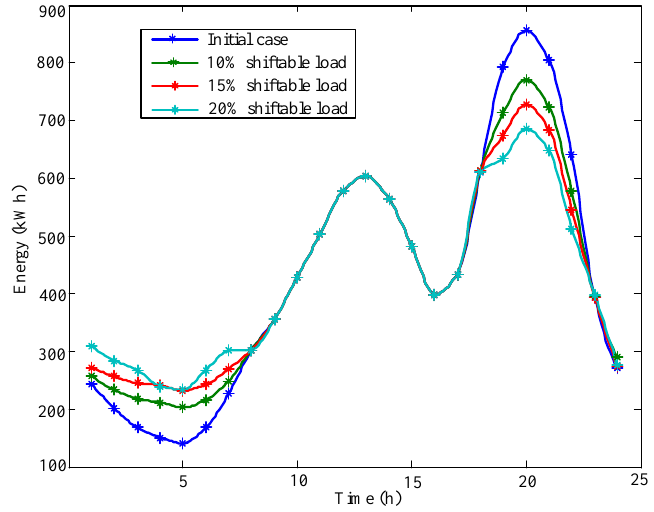
Figure 6. Electrical load curve for different percentages of shiftable